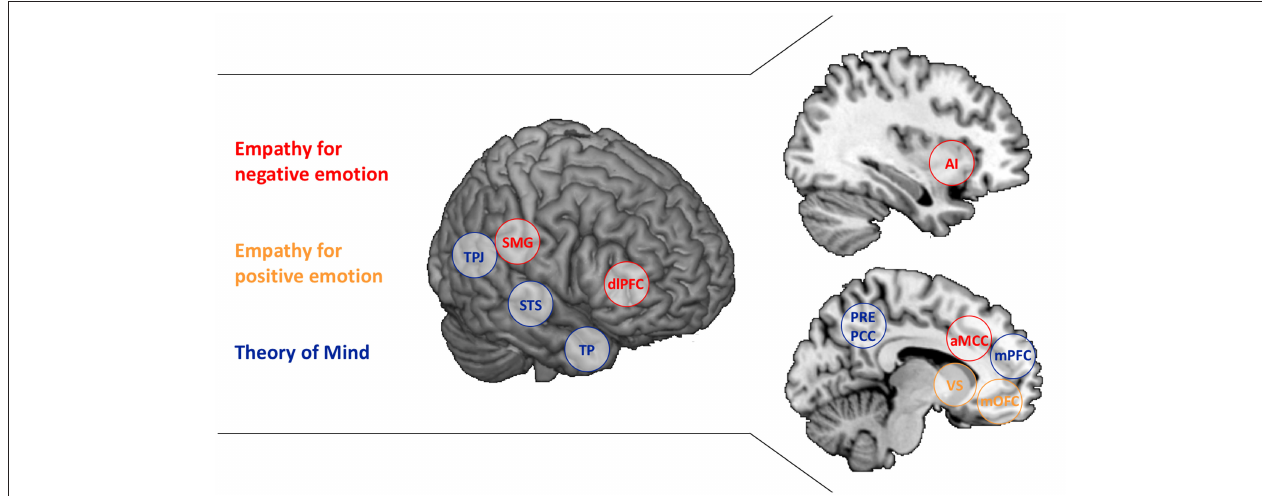
FIGURE 1 | Brain regions associated with Empathy and Theory of Mind. The separable brain regions associated with Empathy for negative emotion (red), Empathy for positive emotion (yellow), and Theory of Mind (blue) are presented. AI, anterior insula; aMCC, anterior middle cingulate cortex; dlPFC, dorsolateral prefrontal cortex; mOFC, medial orbitofrontal cortex; mPFC, medial prefrontal cortex; PCC, posterior cingulate cortex; PCUN, Precuneus; SMG, supramarginal gyrus; STS, superior temporal sulcus; TP, temporal poles; TPJ, temporoparietal junction; VS, ventral striatum. SMG and dlPFC are listed as well as they have been associated with regulating empathic emotion (7).